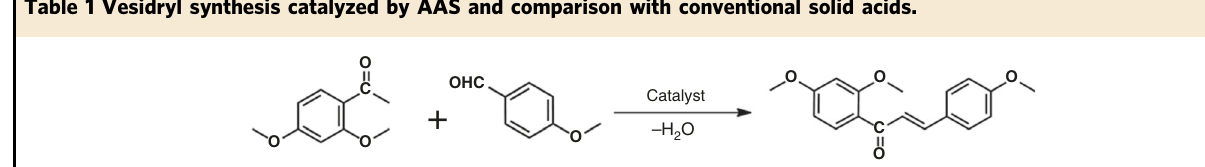
Fig. 2 AAS catalyzed styrene oxide ring-opening. a Reaction kinetics of AAS catalyzed styrene oxide ring-opening by methanol, b total conversion of styrene oxide to 2-methoxy-2-phenylethanol in 6 h of reaction time. Error (s.d.) in the conversion is within Table 1 Vesidryl synthesis catalyzed by AAS and comparison with conventional solid acids.